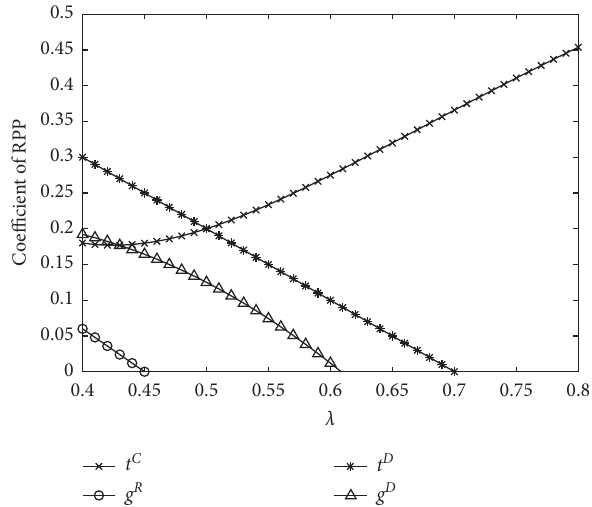
Figure 2: The impact of λ on the reward-penalty coefficient of